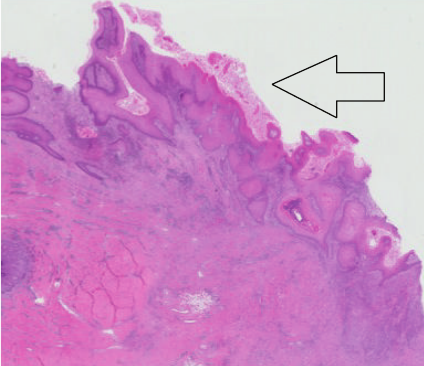
Figure 6: Tissue specimen of debrided right thigh shows skin surface lined by squamous cell carcinoma (open arrow).